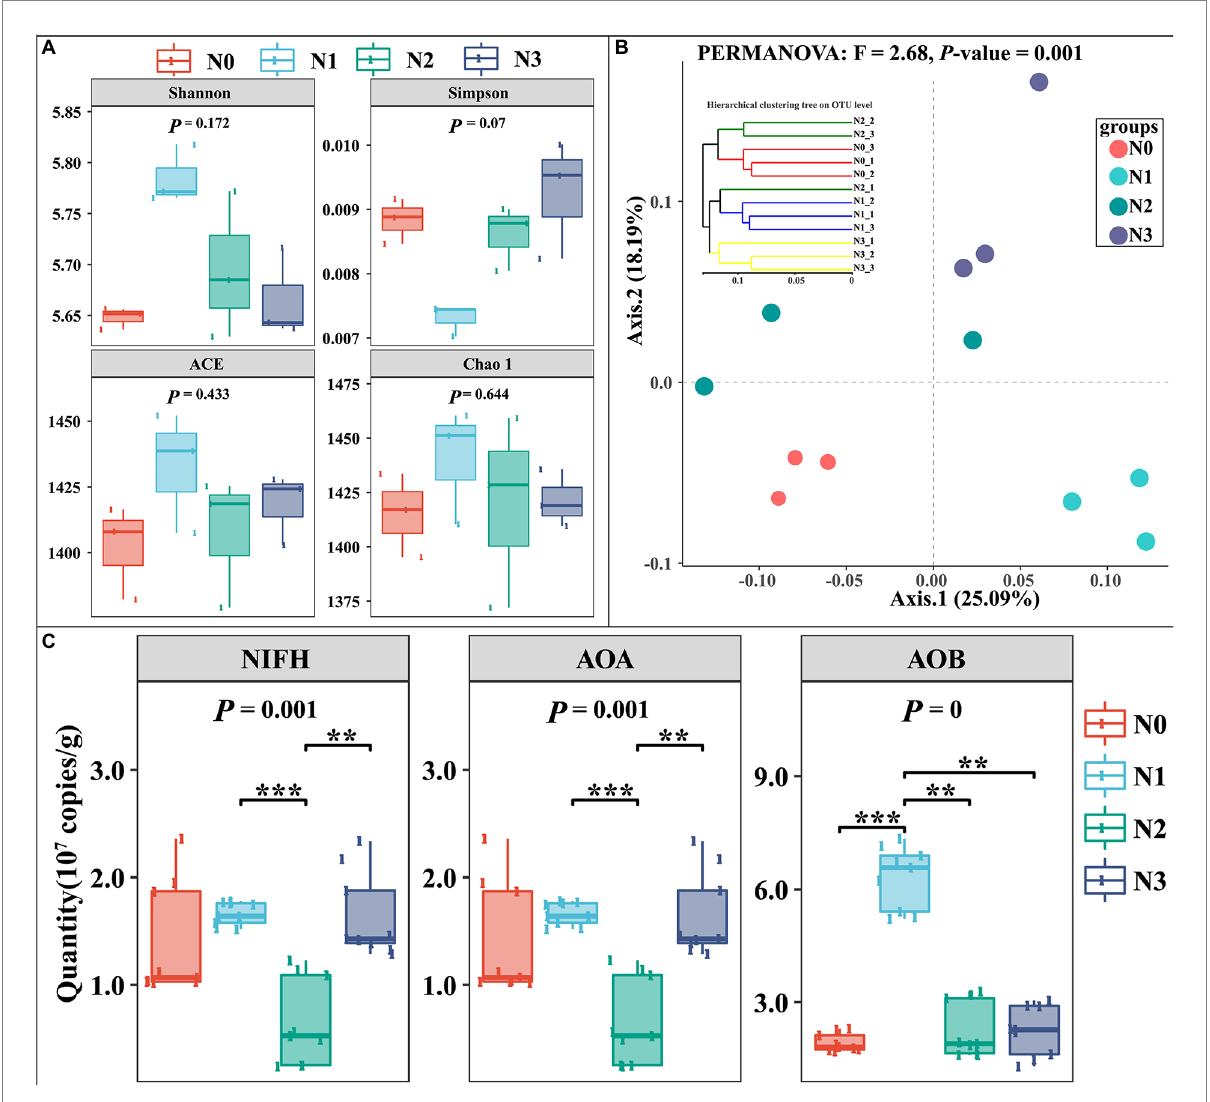
FIGURE 3 Influences of experimental N addition on microbial diversity index and community